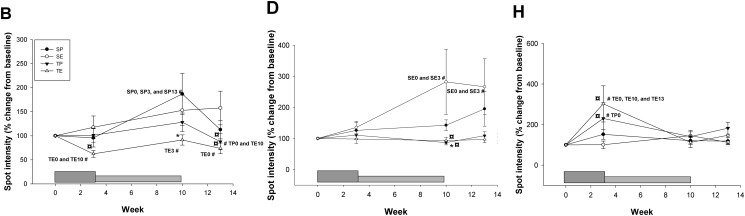
Spots with overall training effect.Average spot intensity for spots B, D, and H, which showed an overall training effect. SP (sedentary-placebo), SE (sedentary-ESA), TP (training-placebo), and TE (training-ESA). The dark grey box at the bottom indicates the boosting period (first 3 weeks) and the light grey box the maintenance period (weeks 4–10), subjects were not treated during weeks 11–13 (wash-out phase). Data are expressed as mean ± SE, level of significance are p<0.05. * significant from SP within same time-point, # significant from different time-point within group (time point are given), ¤ significant from SE within same time-point.